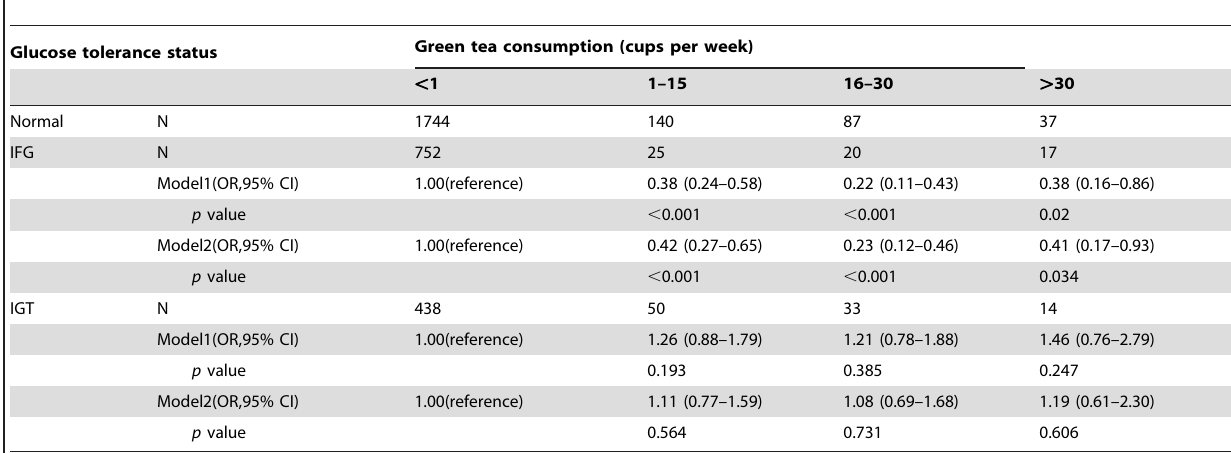
Table 4. Odds ratio for glucose tolerance status grouped according to the level of green tea consumption.